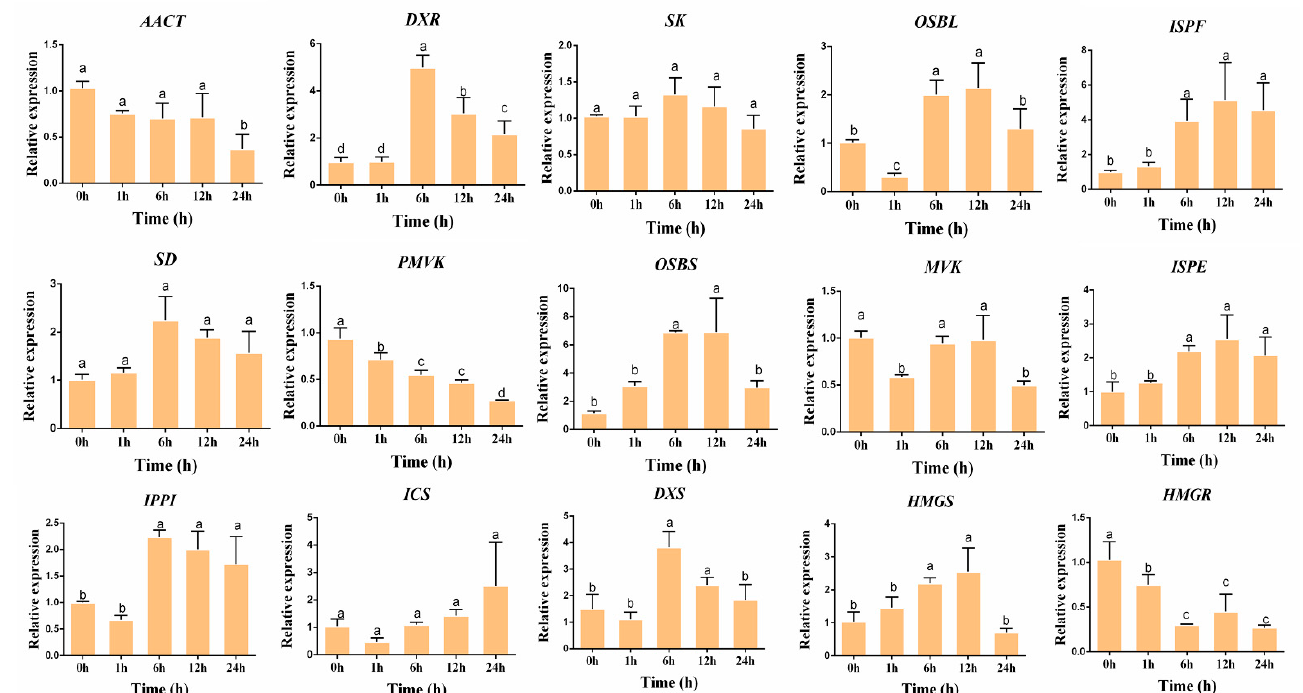
Figure 4. The gene expression in the hairy roots of R. yunnanensis after MeJA treatment for 1, 6, 12, and 24 h. hnRNP was used as the reference gene. The vertical axis represents the relative gene expression level. Different lowercase letters for the same metabolite indicate significant differences ( p < 0.05) between the samples.